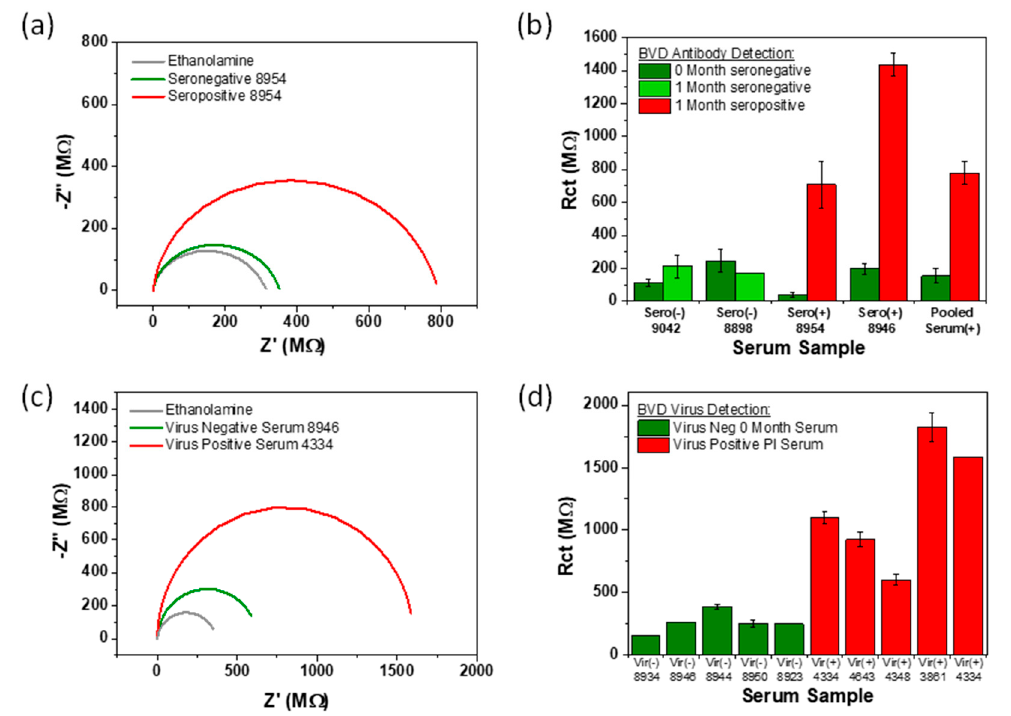
Figure 9. ( a ) Nyquist plots of seropositive and seronegative blood deposition on BVD virus (10 µg/mL) modified microelectrodes, in the presence of 10 mM PBS containing 1 mM FcCOOH. ( b ) Bar chart comparison of seropositive samples and their respective seronegative samples, background subtracted from their respective ethanolamine baselines. ( c ) Nyquist plots of a virus negative and virus positive PI serum, deposited on BVD antibody modified nanoband (measured in the presence of 1 mM FcCOOH). ( d ) Bar chart testing PI serum and virus negative serum samples, background subtracted from their respective ethanolamine baselines.